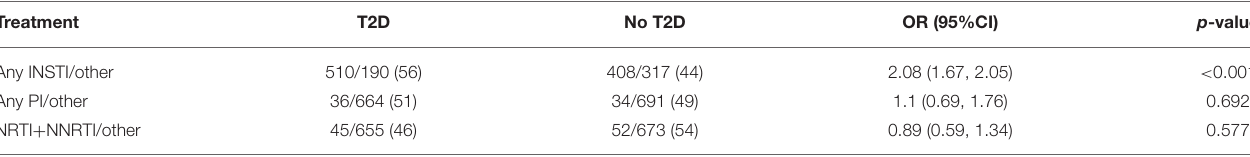
TABLE 4 | Treatments used and association with T2D in the cross-sectional analysis of VACC ¶ . Treatment